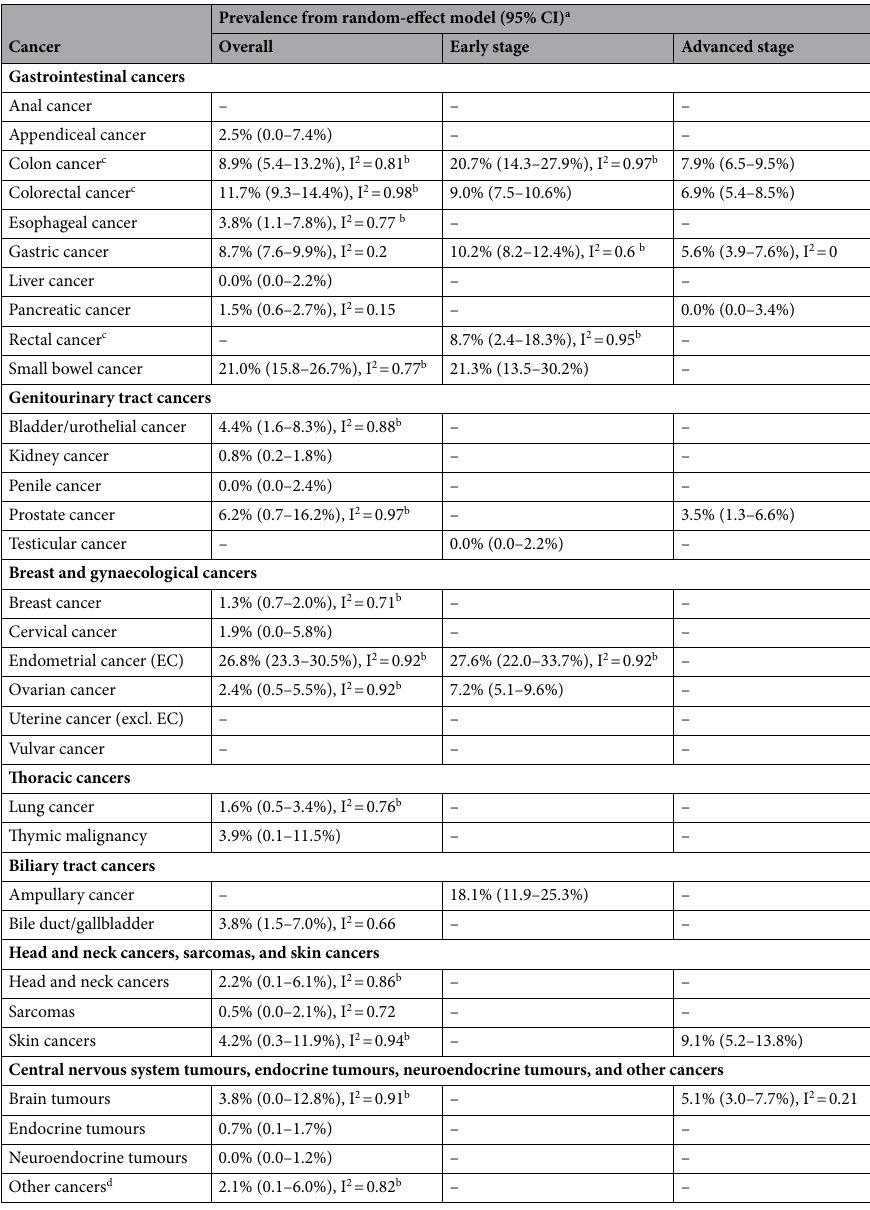
Table 2. Prevalence of mismatch repair deficiency in adult solid tumours by cancer type and stage. a Heterogeneity across studies was presented based on the point estimate of I 2 score and heterogeneity test, if ≥ 2 records were available for each cancer type and stage group. b Statistically significant heterogeneity across studies (p < 0.05). c We analysed the pooled prevalence of pan-tumour biomarkers separately based on estimates including (1) colon cancer only, (2) rectal cancer only, and (3) tumours at any sites in the colon and the rectum, obtaining pooled prevalence estimates described as “colon cancer”, “rectal cancer”, and “colorectal cancer”, respectively. d Other caners include cancer of unknown primary, cancer of unknown primary-neuro, germ cell tumour, peritoneal cancer, and underspecified cancer. See Supplementary Tables S7 and S10 for the number of records included in the analysis and the